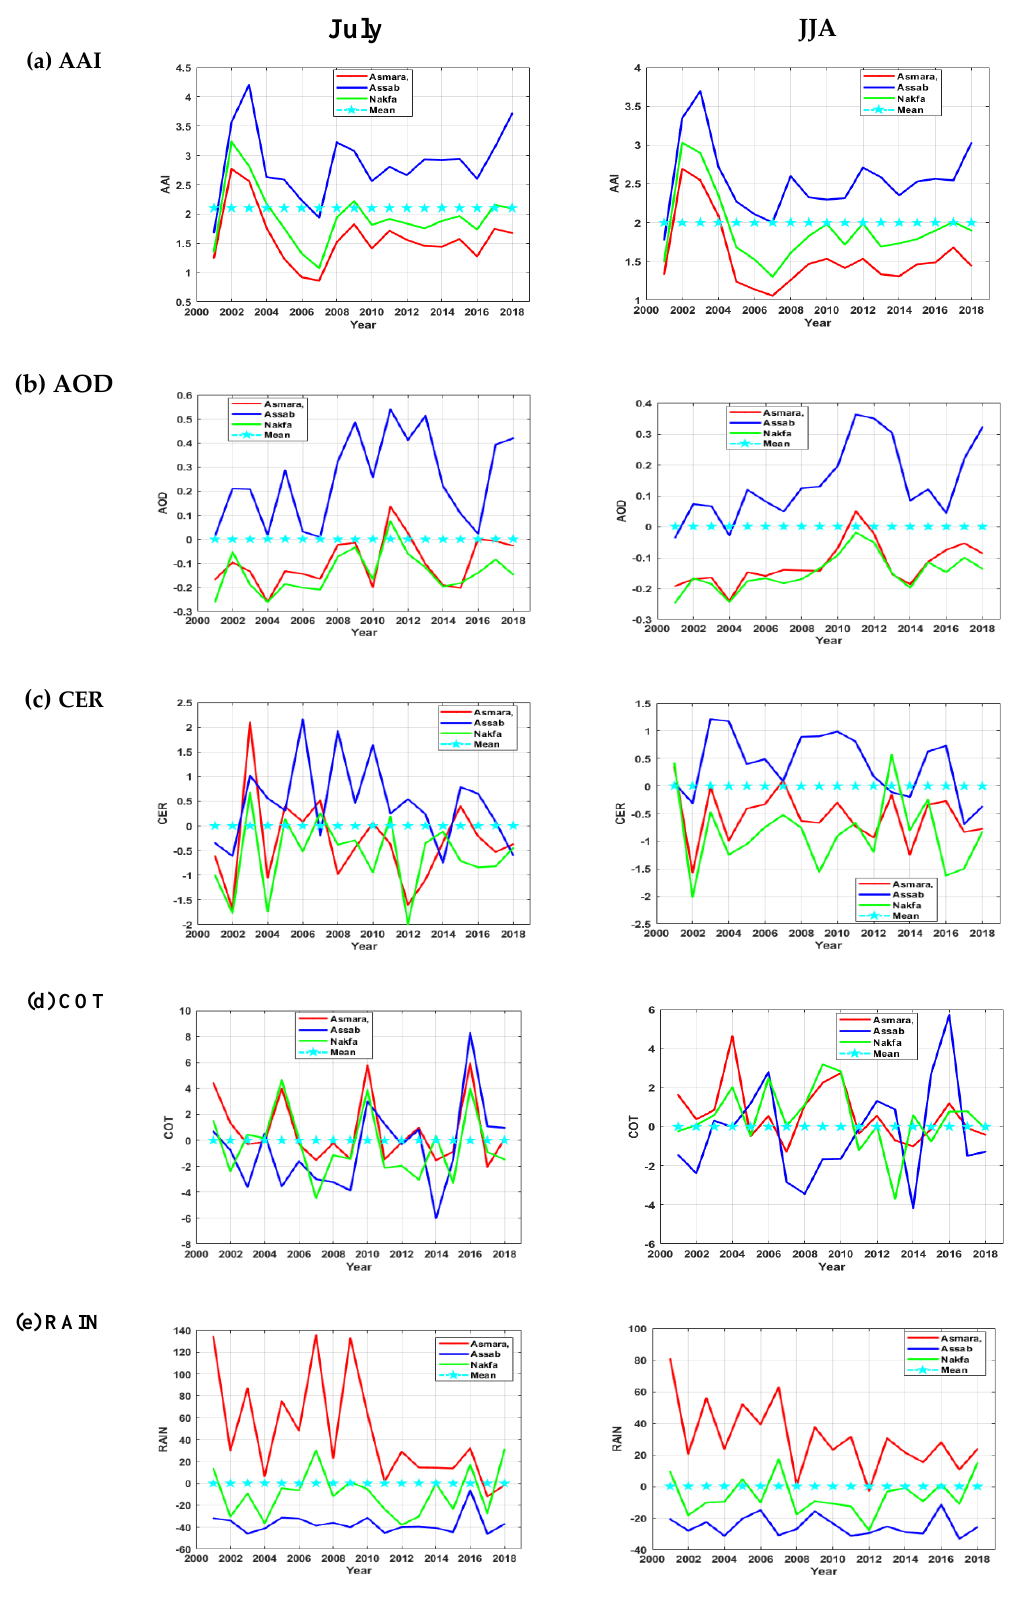
Figure 3. Time series with its mean (light blue dots) for ( a ) absorbing aerosol index (AAI) and anomaly in comparison to the mean anomaly (light blue dots) for ( b ) aerosol optical depth (AOD), ( c ) cloud effective radius (CER) ( µ m), ( d ) cloud optical thickness (COT), and ( e ) rainfall in mm/h in Asmara, Assab, and Nakfa from 2001–2018.